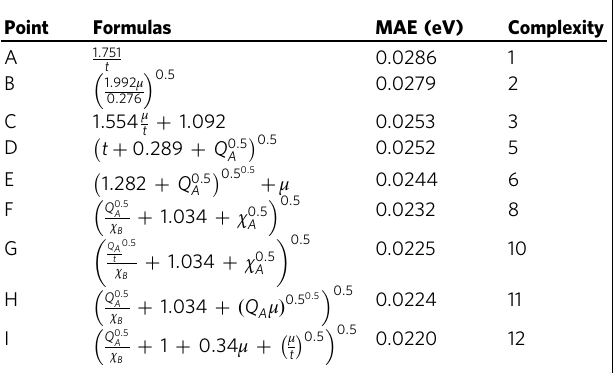
Table 2 The nine mathematical formulas at the Pareto front in Fig. 3a. Point Formulas